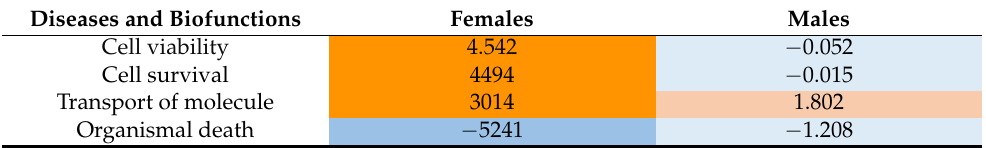
Table 2. Differentially activated and inhibited diseases and biofunctions.